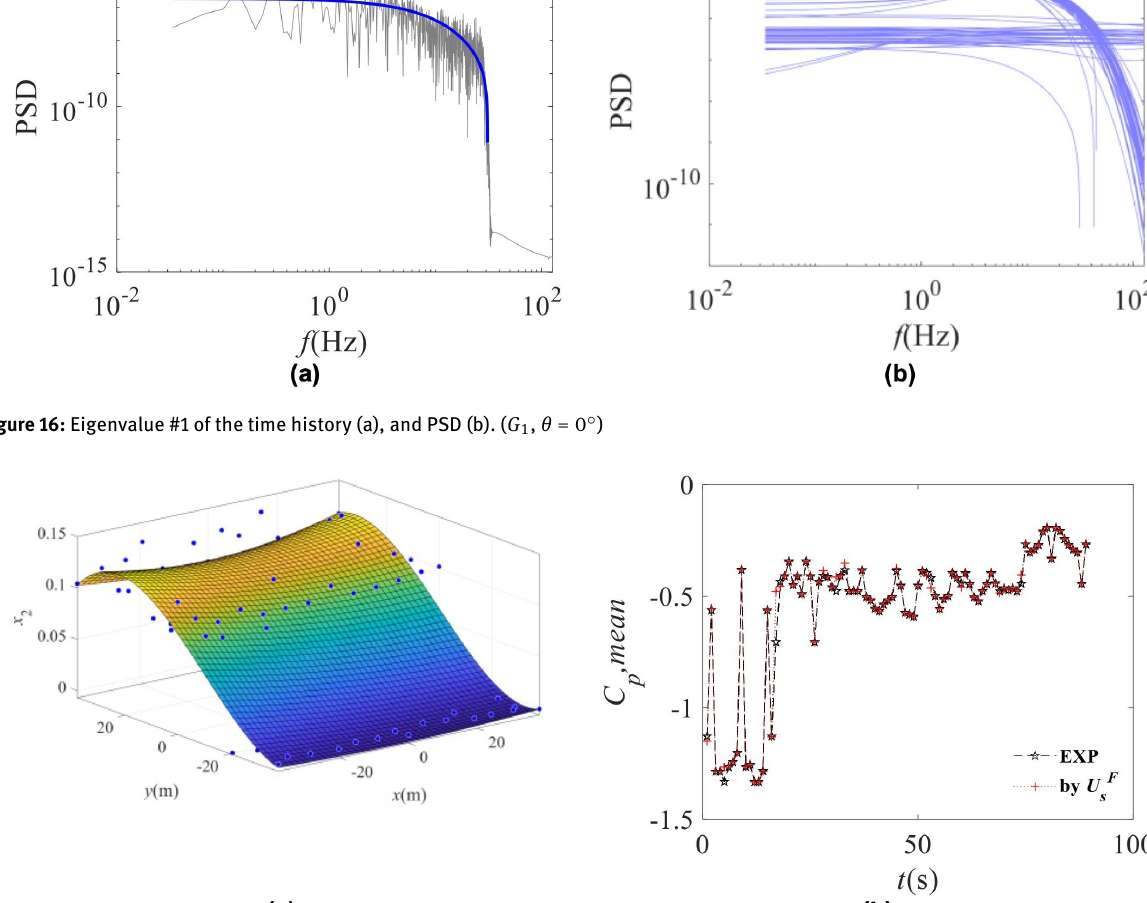
The nine coefficients of the fitting polynomial for all four coefficients x 1,..4 defined in Eq. (6), for all geometries listed in Table 1 and all three wind angles investigated, are given in Appendix